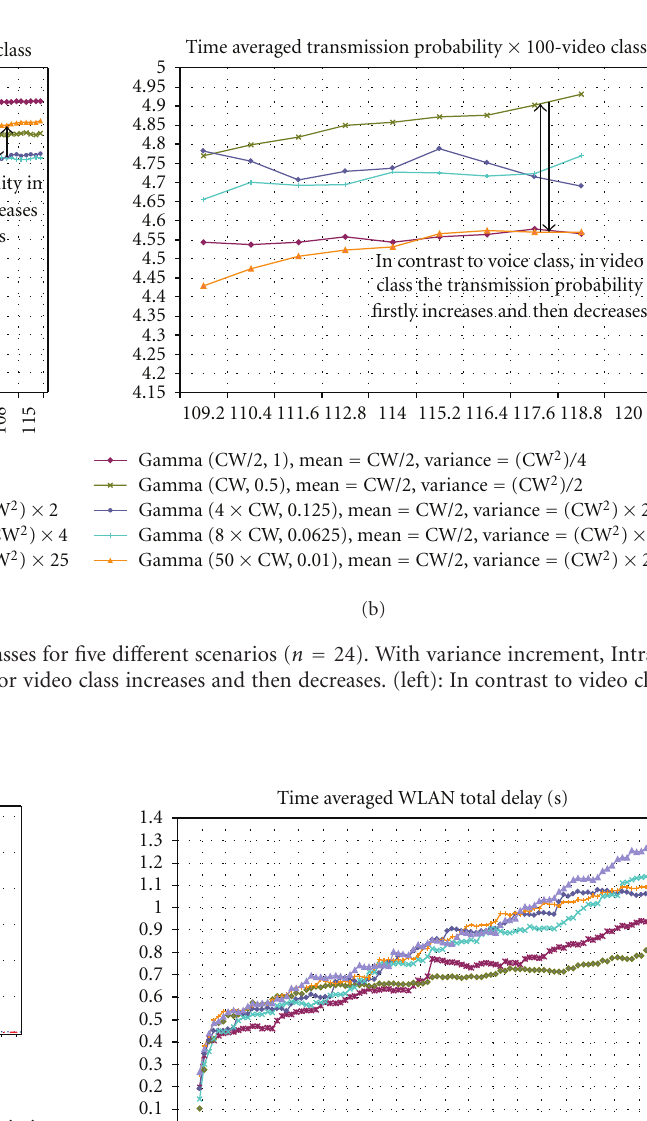
Figure 13: Normalized throughput and successful transmission probability versus transmission probability ( τ i ) for a network of n = 10. When several classes contend for channel access, the priority class (voice, here) survives in Region1 while other classes are sentenced to be in Region 2.